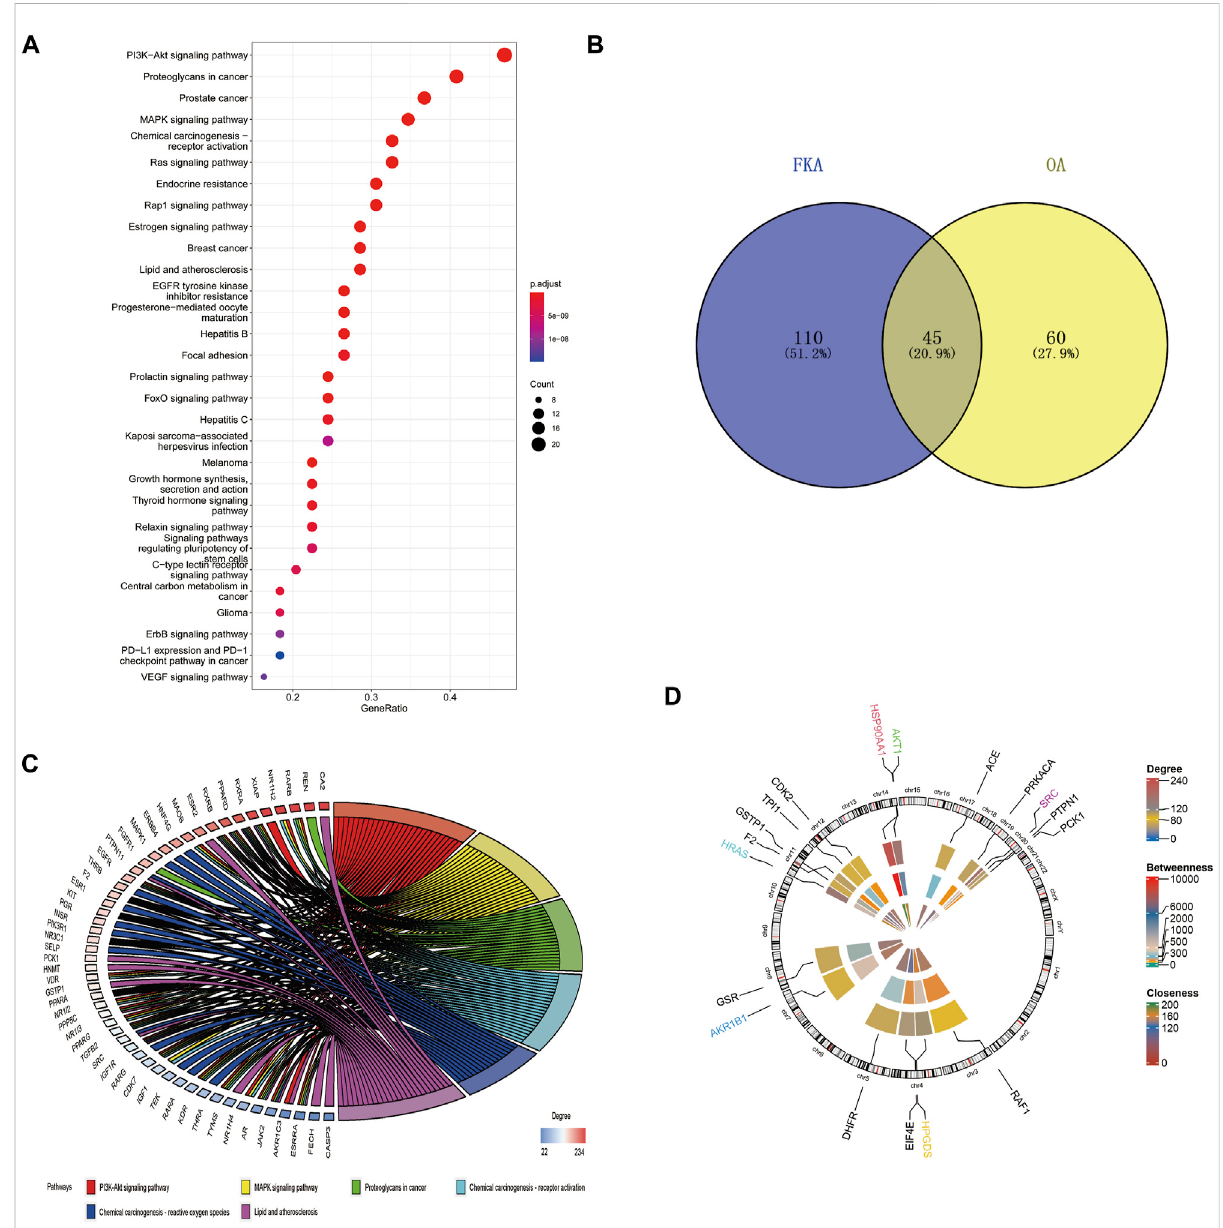
FIGURE 7 Bioinformatics analysis of FKA pathways and target genes (A) KEGG pathway enrichment analysis of FKA target genes. (B) The intersection between FKA-related KEGG pathways and OA-related pathways. (C) Top six paths in cross paths (KEGG enriched chord diagram). (D) Assessment of Centrality and chromosomal investigation of FKA-related central